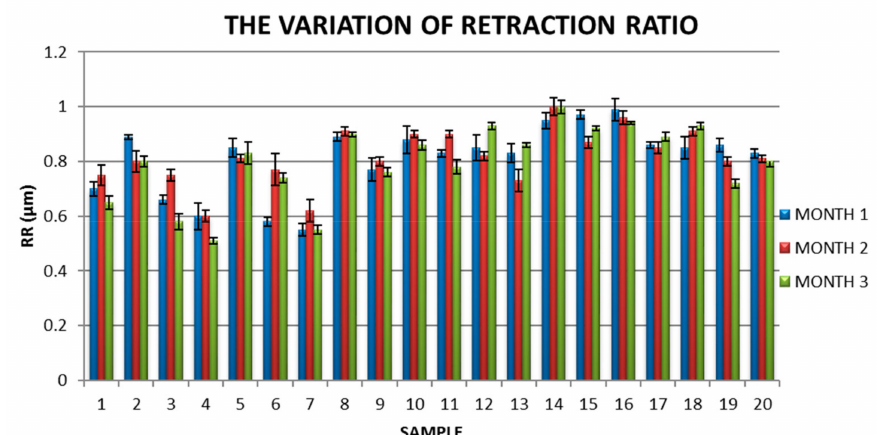
Figure 6. Variation of film thickness during tested time.